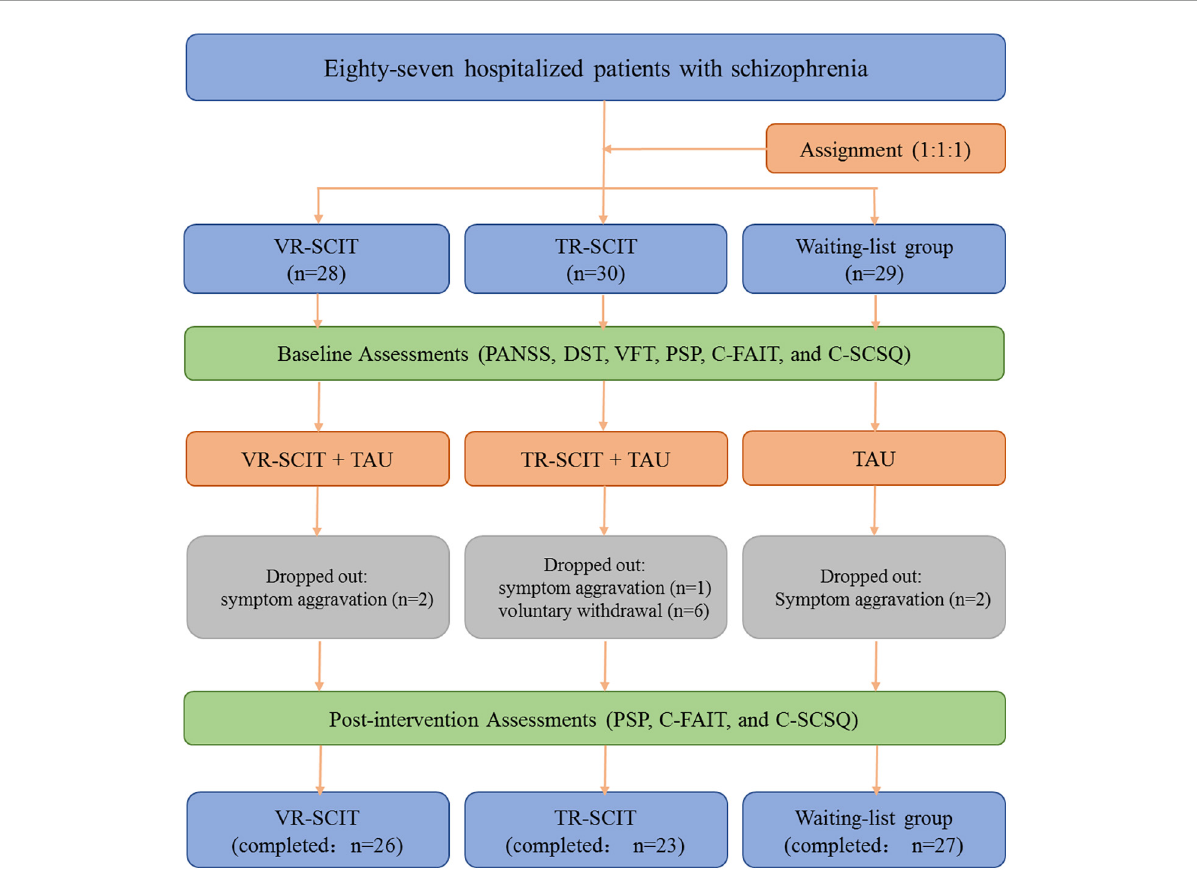
FIGURE1 Flowchart of the present work. VR-SCIT, virtual reality based social cognition and interaction training; TR-SCIT, traditional social cognition and interaction training; PANSS, positive and negative syndrome scale; PSP, personal and social performance scale; DST, digit span test; VFT, verbal fluency test; C-FAIT, Chinese version of face affective identification task; C-SCSQ, Chinese social cognition screening